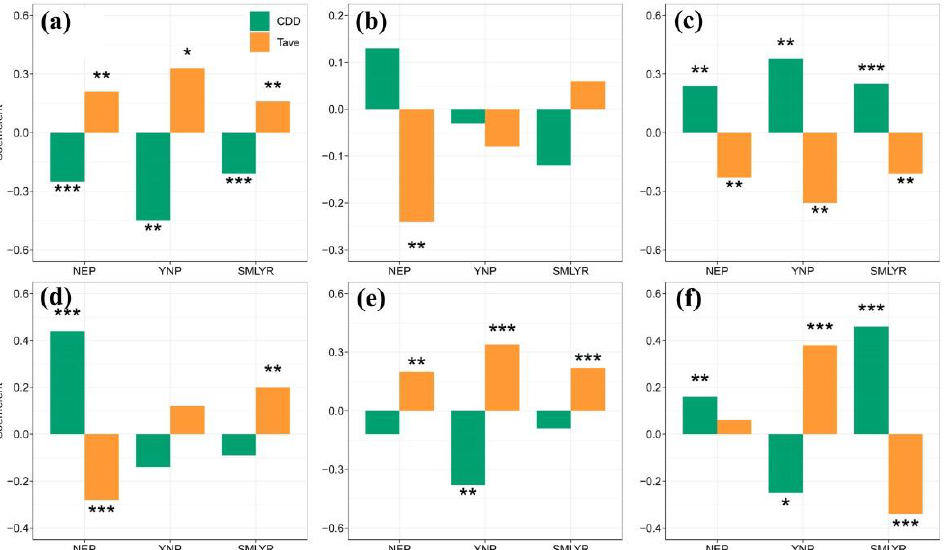
Figure 5. Correlations between first-difference temperature indices and first-difference rice yield ( a ), number of grains per panicle ( b ), percentage of undeveloped grain ( c ), percentage of partially developed grain ( d ), 1000-grain weight ( e ), and growing duration length ( f ), during heading and flowering. Correlations significant at the 0.05 level are marked by *, while those significant at the 0.01 level are marked by ** and those significant at the 0.001 level by ***.